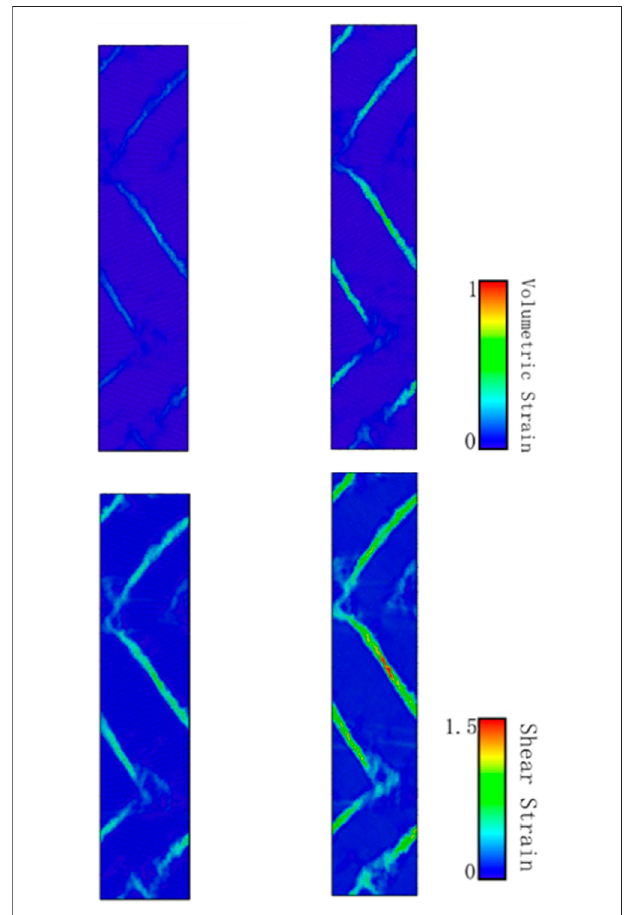
FIGURE 12 | The cross-section of atomic shear strain distributions and volumetric stress at strain of 10%,